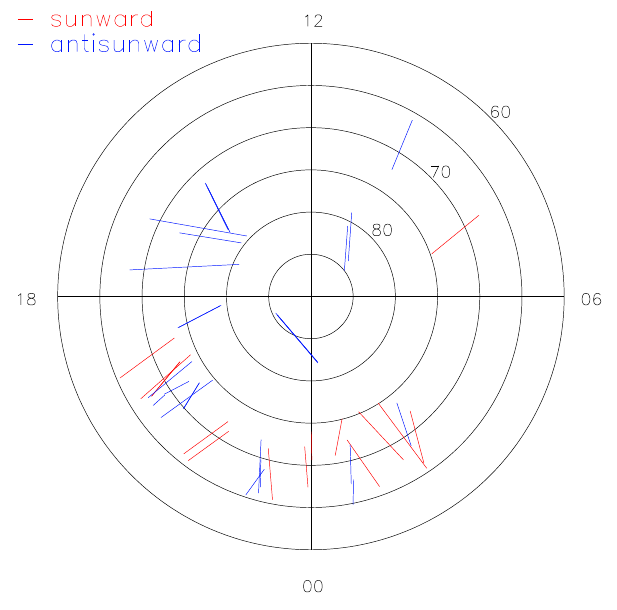
Fig. 3. A polar plot of all Cluster oval crossings during 2001– 2003 that contain intense E-field events above 500mV/m. The red and blue lines correspond to poleward oval crossings with average plasma flow direction in sunward and in anti-sunward direction, re- spectively. The poleward end of each line corresponds to the polar cap